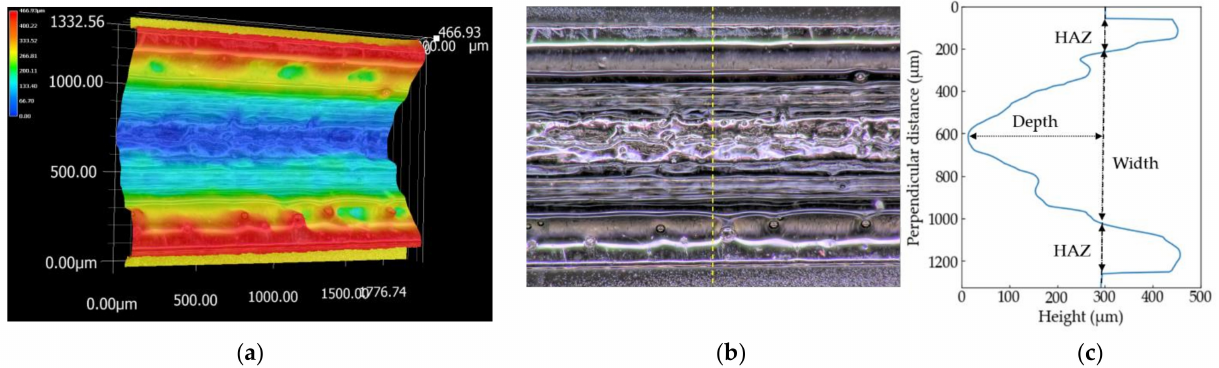
Figure 5. Three-dimensional shape ( a ), optical image ( b ) and the height profile at the yellow dash line ( c ) of the PS sample measured by the digital microscope. The sample is processed at S = 150